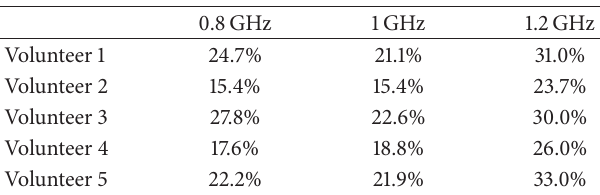
Table 2: Noise metric 𝑁 of experimental